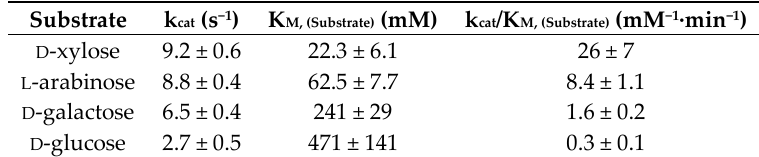
Figure 6. Michaelis-Menten curves with the substrates ◆ D -glucose, ▲ D -galactose,  L -arabinose and ■ D -xylose. The concentration of sugars was varied and concentration of NADPH kept at 0.4 mM, measurements were taken at 30 °C. Table 4. Substrate specificity of the investigated xylose reductase. The enzyme showed a clear preference for D -xylose (k cat /K M ). Measurements were taken at 30